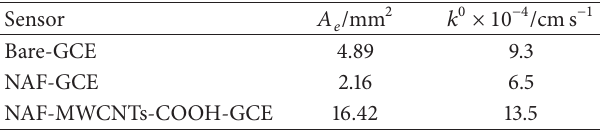
Figure 1: CVs for NAF-GCE-CAT (a) and NAF-MWCNTs-COOH-GCE-CAT (b) at different scan rates (10–500 mVs −1 ) in deoxygenated PBS buffer solution. Table 1: Electroactive area and heterogeneous standard rate con- stant of bare sensor and after modification steps. Sensor 𝐴 𝑒 /mm